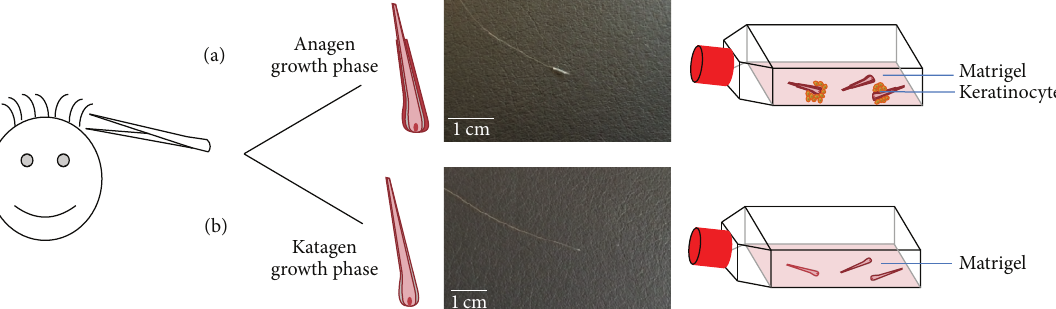
Figure 3: Comparison between plucked hair with good and bad roots. (a) Plucked hair with outer root sheath in the anagen growth phase transferred to a Matrigel coated culture flask. Keratinocytes grow out after 3–7 days. (b) Plucked hair without outer sheath root in katagen growth phase. No keratinocytes will grow out.